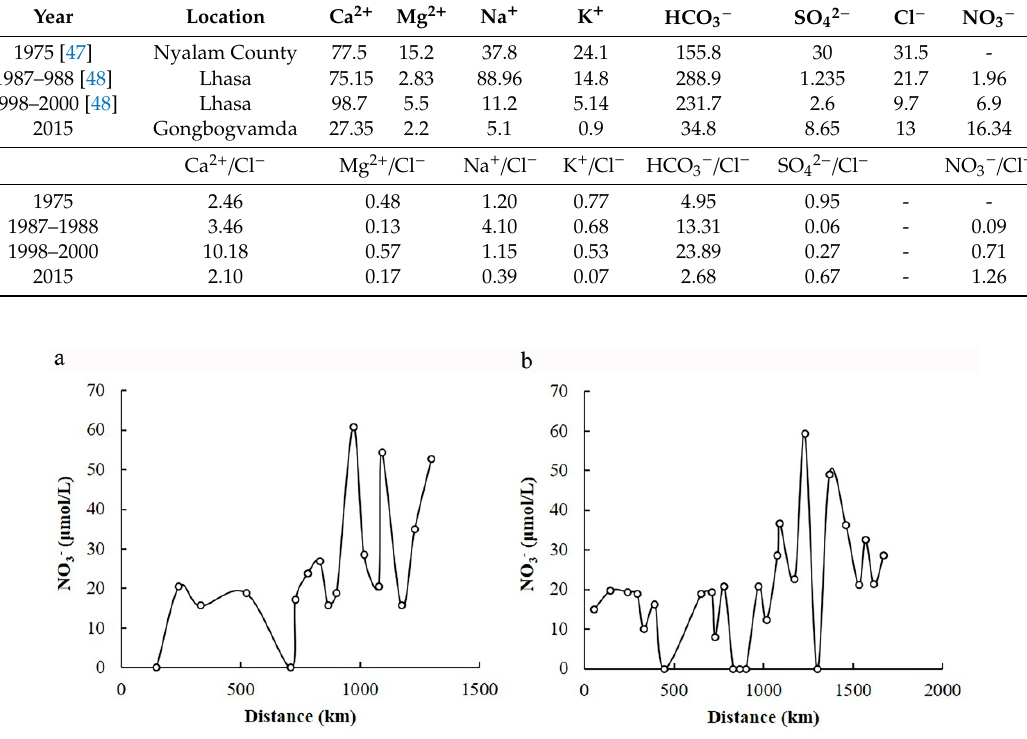
Figure 4. NO 3 − concentration along the mainstream of the Yarlung Tsangpo River during di ff erent Figure 4. NO 3– concentration along the mainstream of the Yarlung Tsangpo River during different periods: ( a ) September 2008 and ( b ) September 2015 ( µ mol / periods: ( a ) September 2008 and ( b ) September 2015 ( μ mol/L).